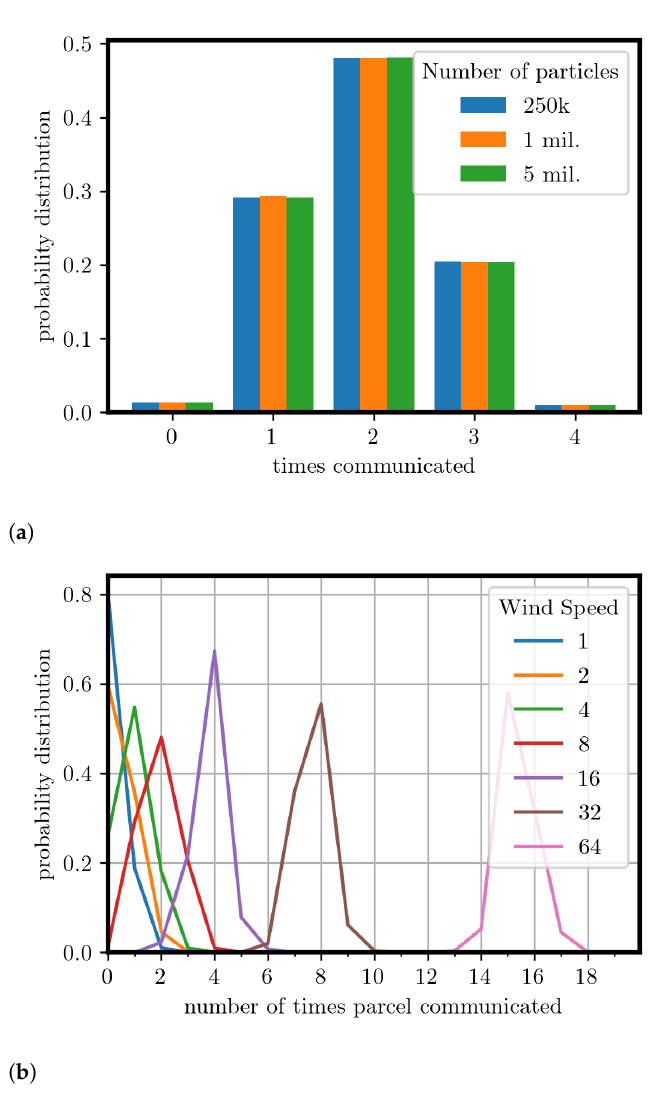
Figure 13. ( a ) Distribution of particles communicated with the change in particle count. ( b ) Distribu- tion of particles communicated with the change in wind